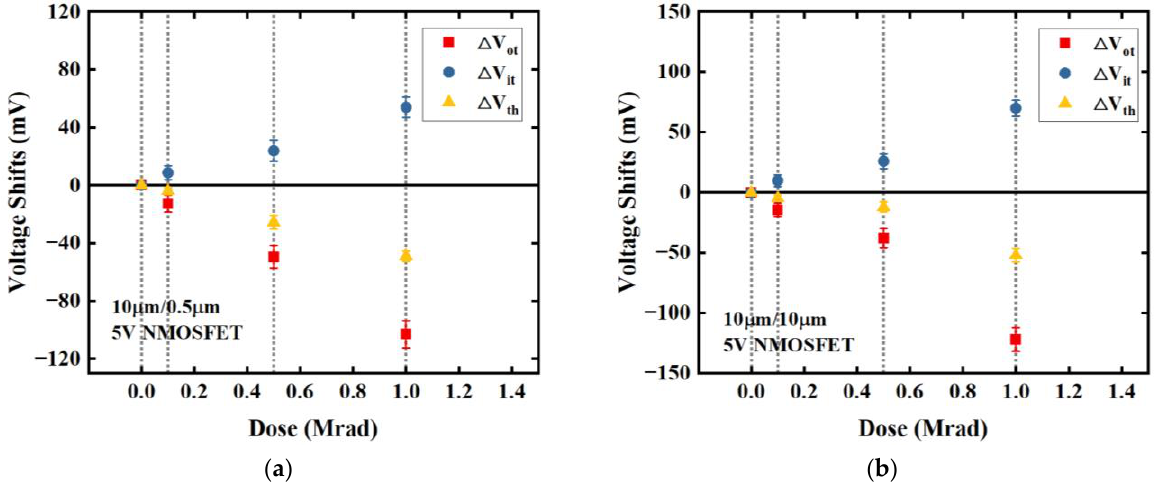
Figure 5. Net threshold-voltage shifts and components due to oxide-trap charge and interface-trap charge as a function of irradiation dose for the 5V NMOSFETs ( a ) with a width of 10 μm and a length of 0.5 μm, as well as those ( b ) with a width of 10 μm and a length of 10 μm. All devices were irradiated up to 1 Mrad(Si) under the “on” bias condition.